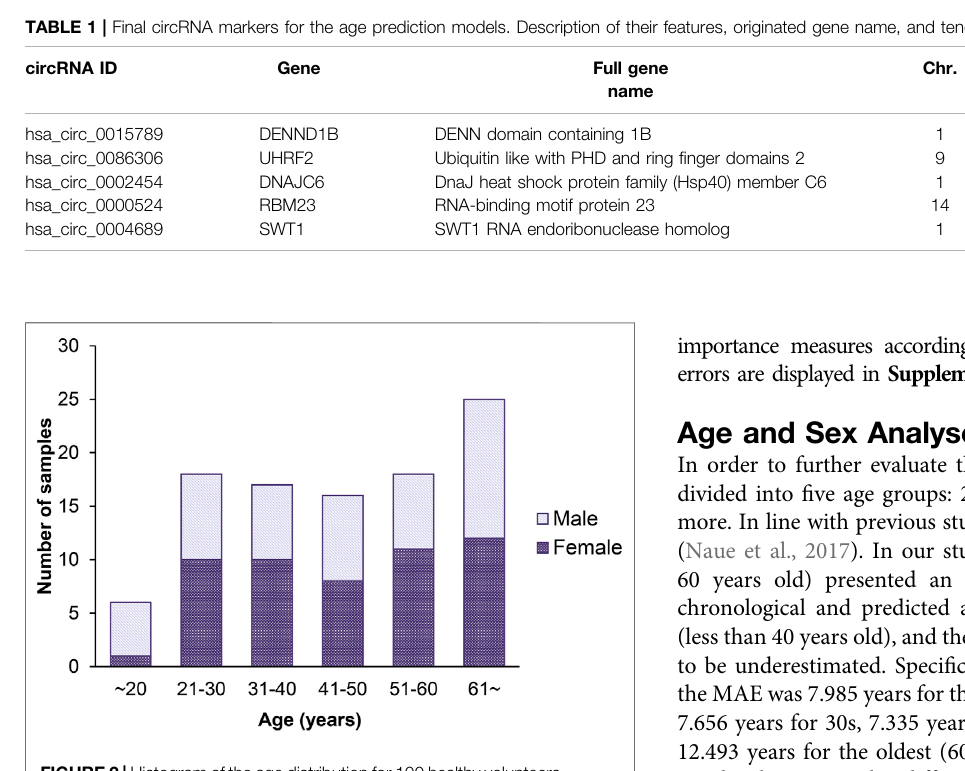
Frontiers in Genetics |